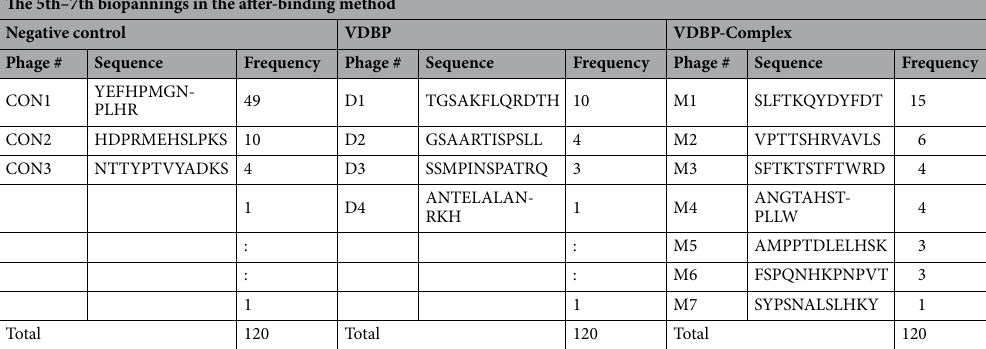
Table 4. DNA sequences of the 120 clones for each material-specific binding phage using the after-binding method. From the 5th to the 7th biopanning, the DNA sequence of a total of 120 clones for each material- specific biding phage using the after-binding method was analyzed. Forty phage clones were picked for each biopanning. These sequences were ordered by the highest frequency appearance and significance. Phage # has been renumbered by composing this table.